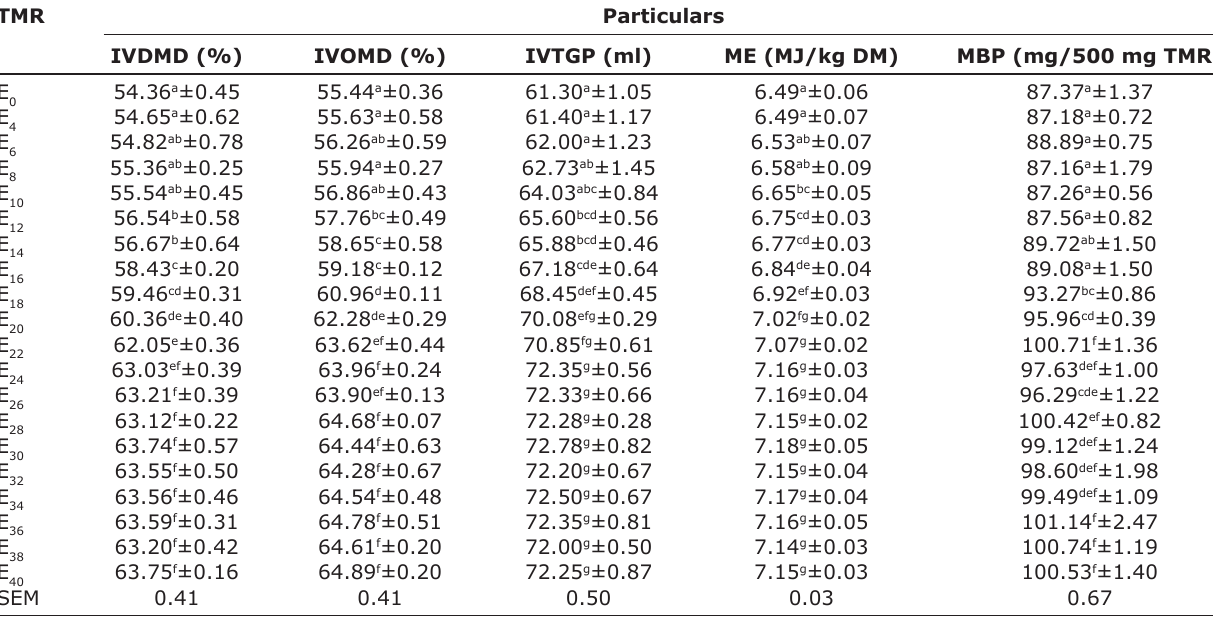
Table-2: Average IVDMD, IVOMD, IVTGP, ME and MBP of TMR containing different levels of exogenous fibrolytic enzymes. TMR